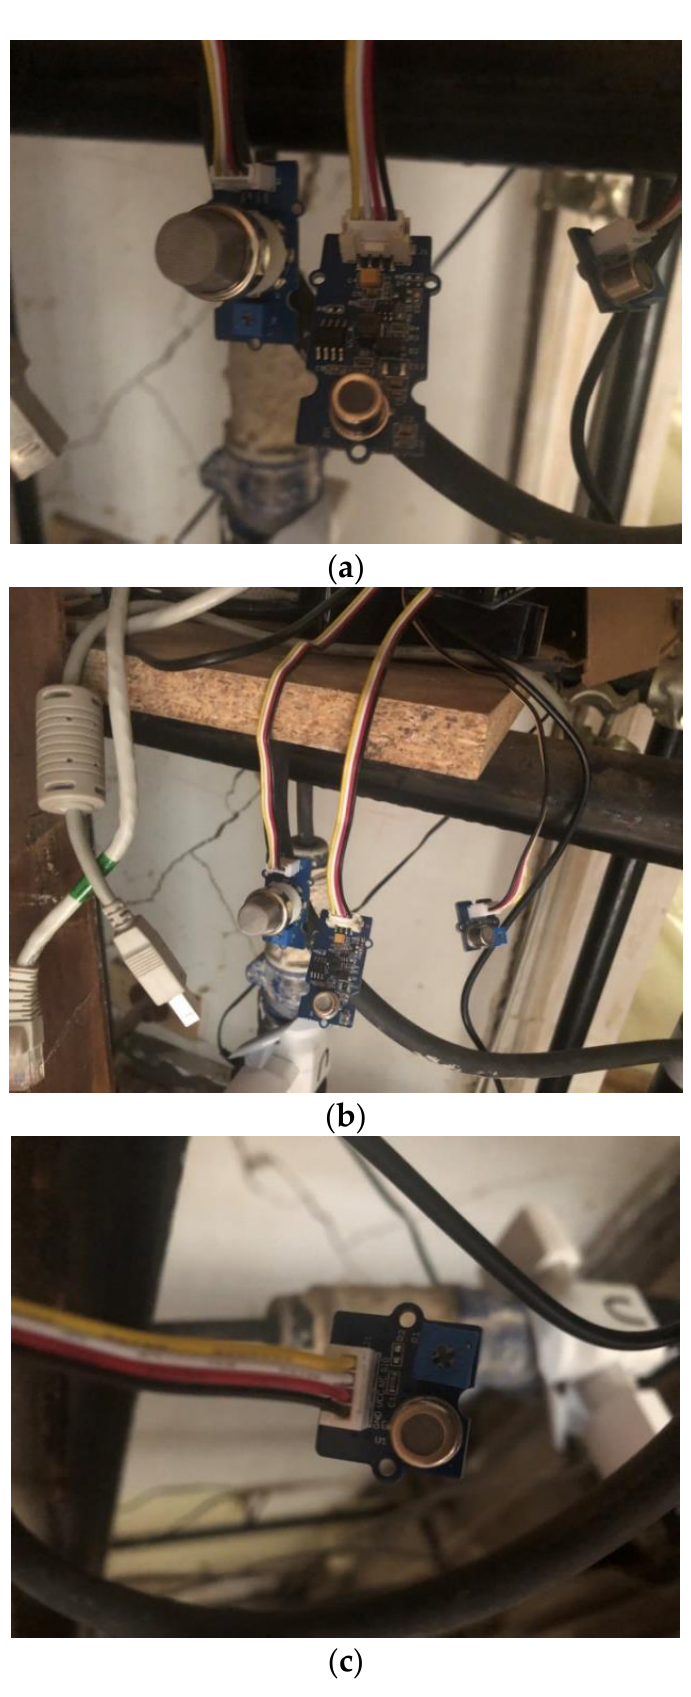
Figure 8. Installed sensors: ( a ) indoor air quality sensors, ( b ) gas sensors and ( c ) VOC sensors.